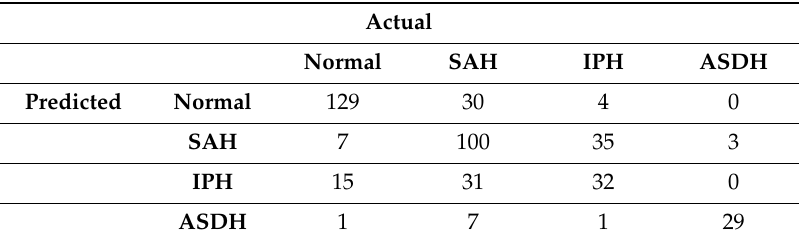
Table 3. Multi-Class Classification for Normal and Abnormal CT Scans.